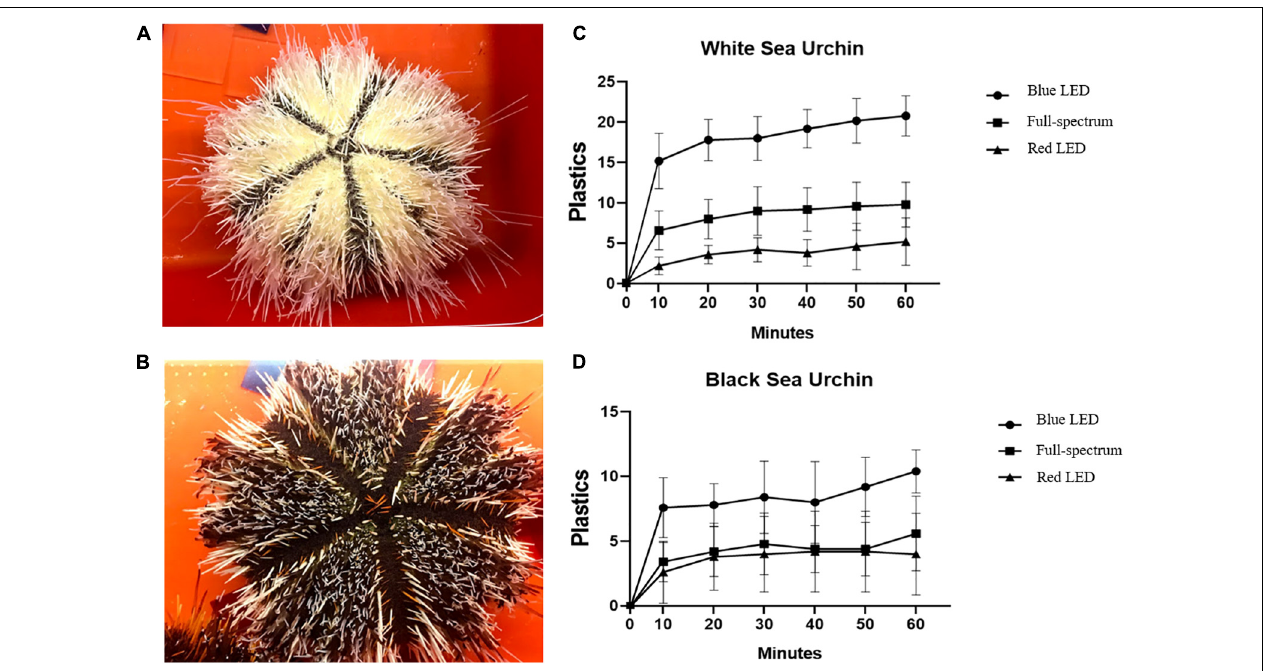
FIGURE 2 | Numbers of plastics cover on (A,C) white and (B,D) black T. gratilla under blue-, full-spectrum- and red LED illumination. Each value represents mean ± SD.